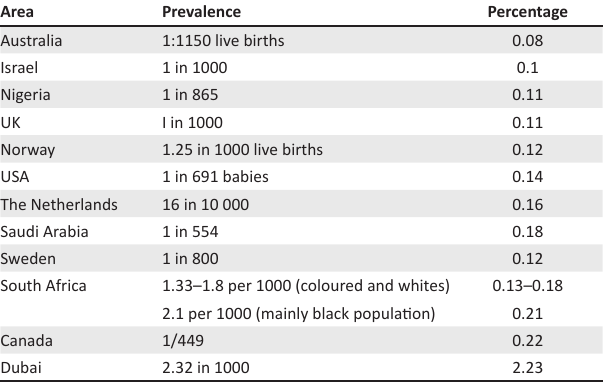
TABLE 1: Prevalence of live births of Down syndrome across